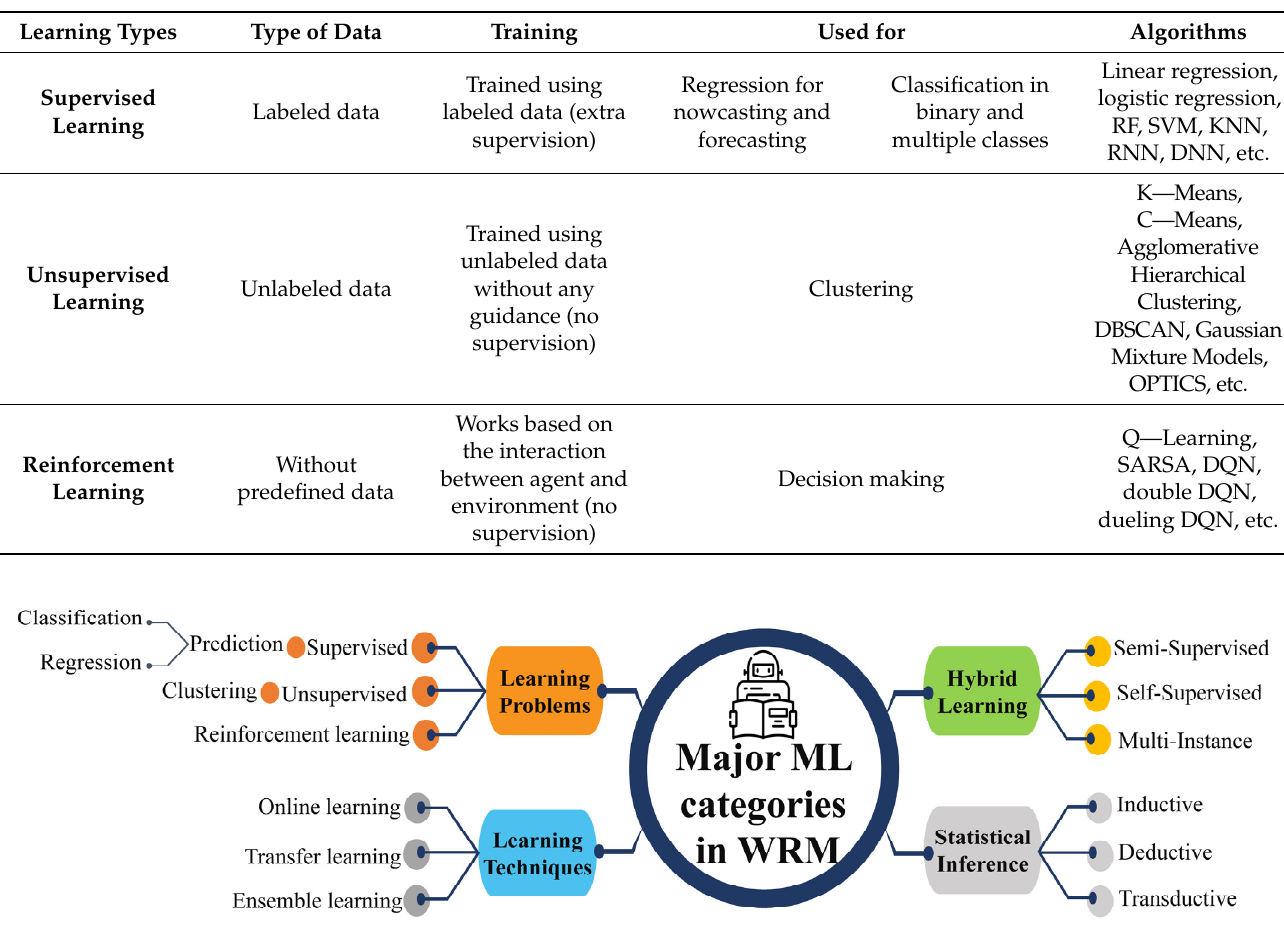
Figure 2. Four major types of machine